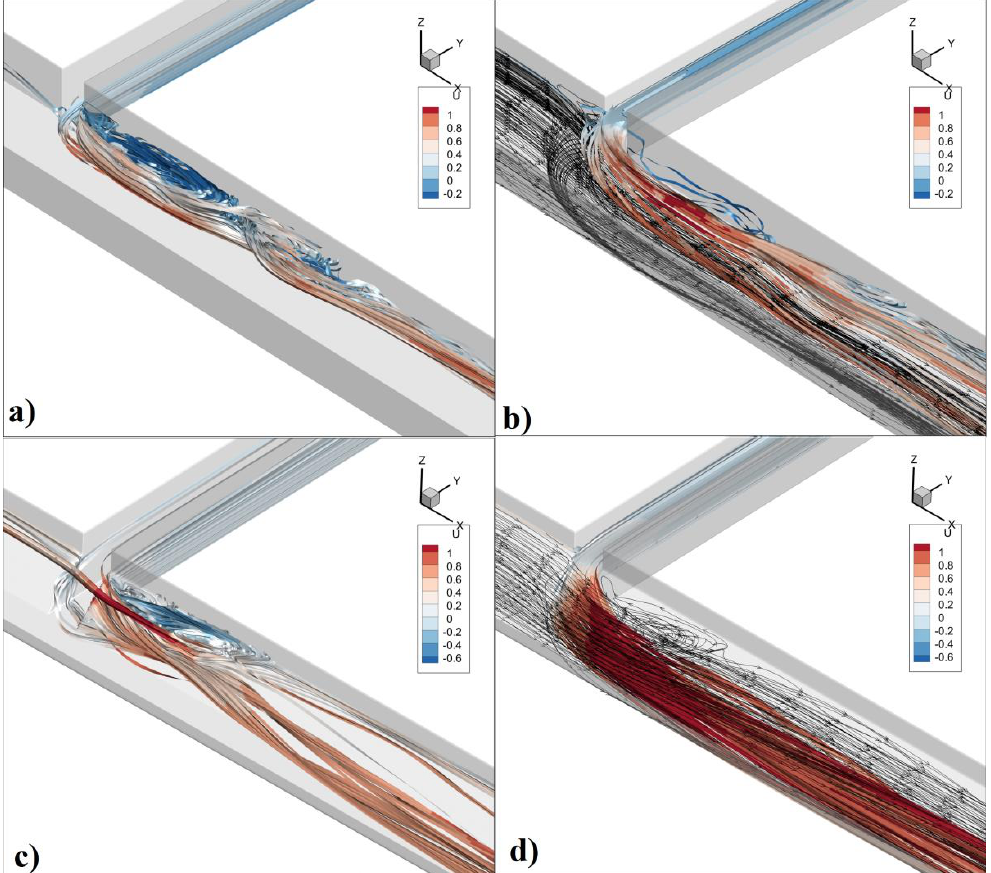
Figure 14. Three-dimensional streamlines at the confluences with W* = 0.25 and ( a,b ) rectangular and ( c,d ) trapezoidal geometry.